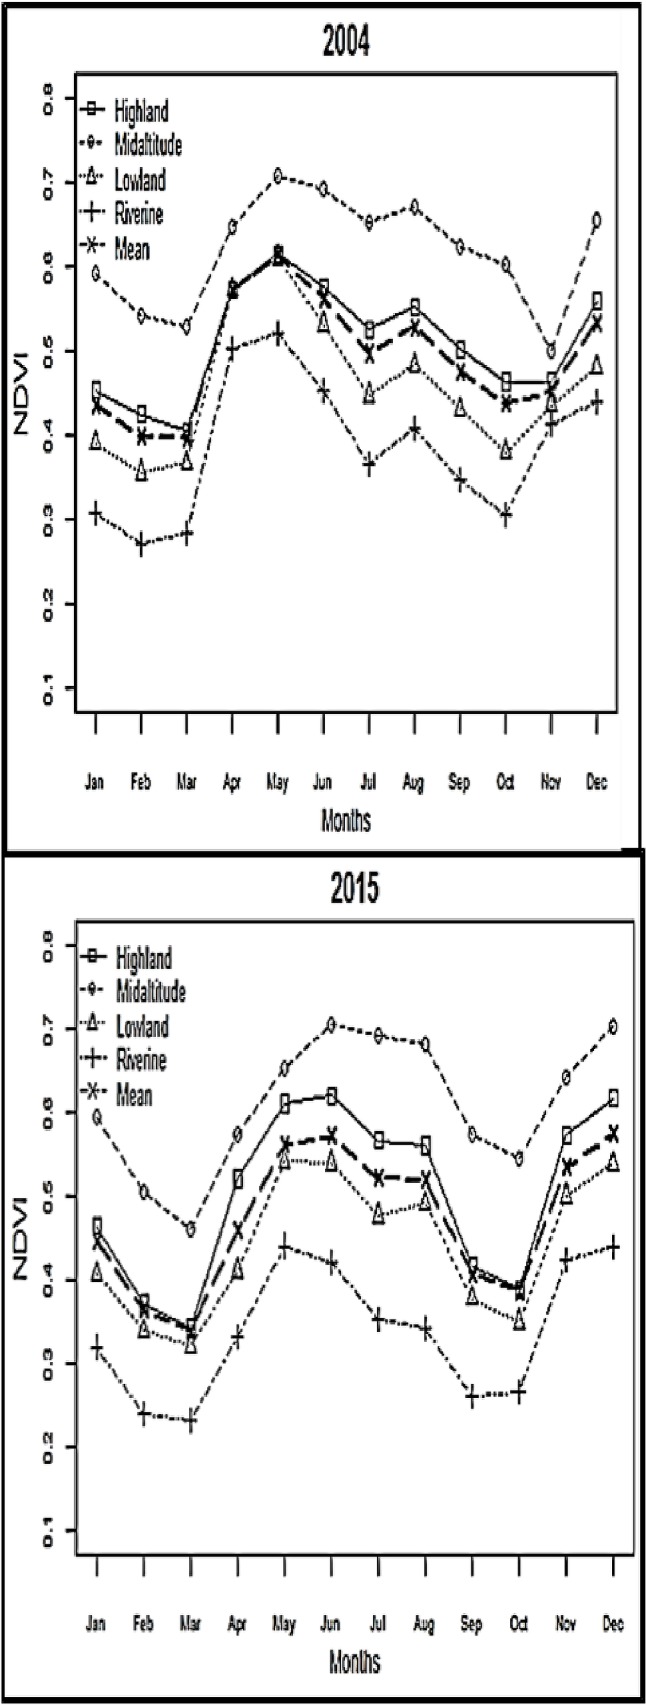
The annual cycle of NDVI for the years 2004 and 2015 as examples.Mean monthly values are indicated in bold.